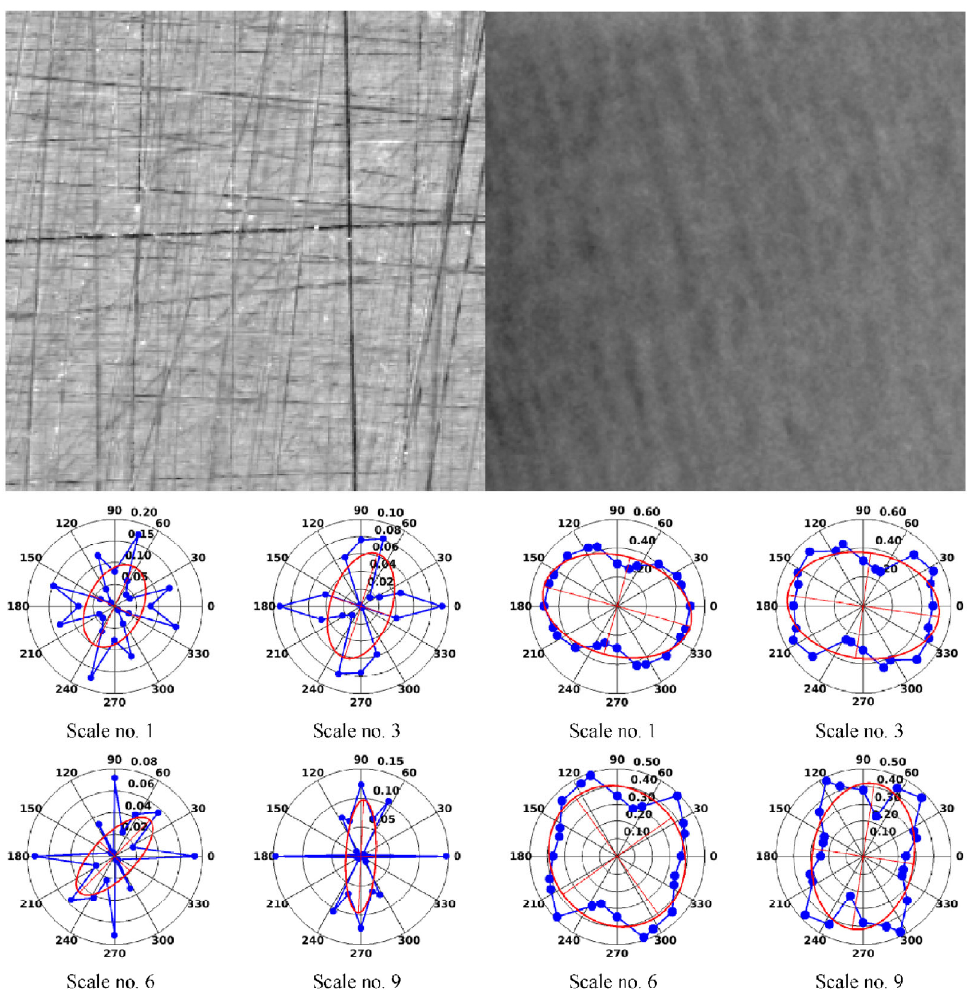
Fig. 6 Range image of the surface topography and x-ray region of interest of a normal knee together with the DFS analysis